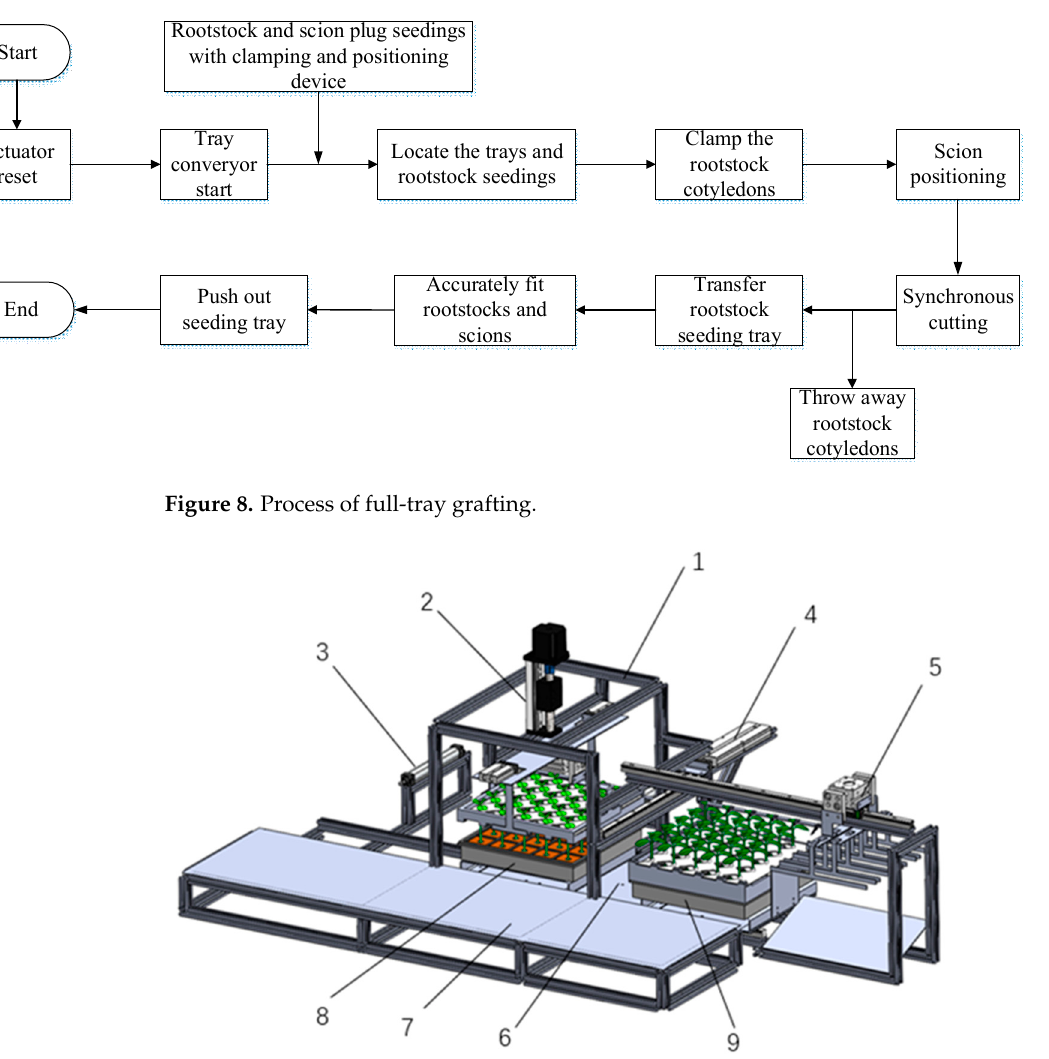
Figure 9. Three dimensional model of whole plate grafting machine: 1. Rack; 2. Clamping-lifting device; 3. Seedling-lowering device; 4. Synchronous-cutting device; 5. Clamping and transferring device for the upper half of the rootstock seedlings; 6. Plug tray-positioning device; 7. Upper seedling platform; 8. Scion-seedling plug tray; 9. Rootstock-seedling plug